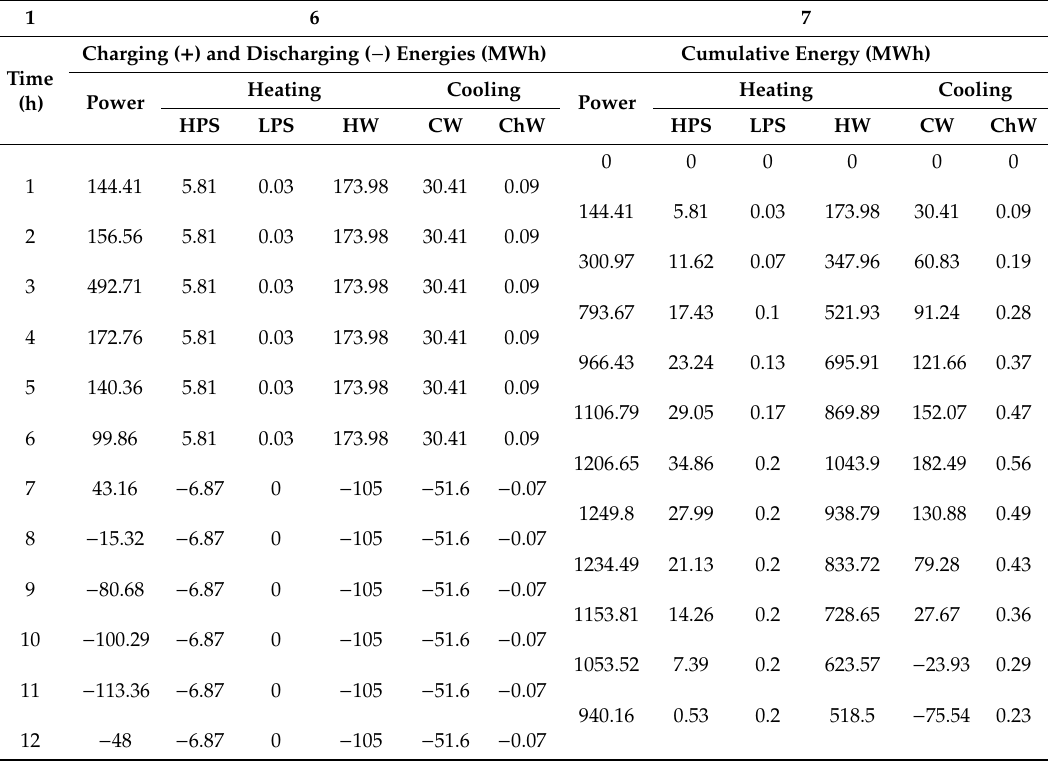
Table A23. TriGenSCA for final trigeneration PWR NPP without integration from time 1 to 12 h.